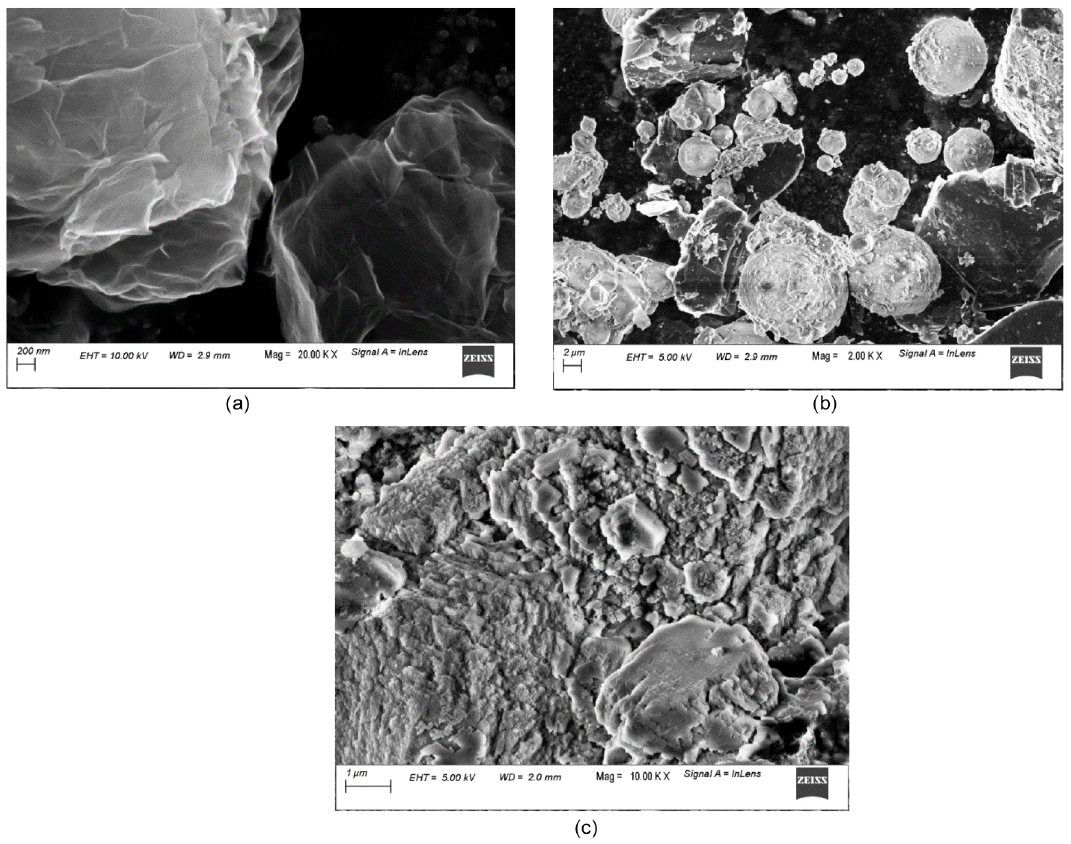
Fig. 2. SEM images of (a)RGO, (b) SiC, (c) RGO-SiC-LLDPE